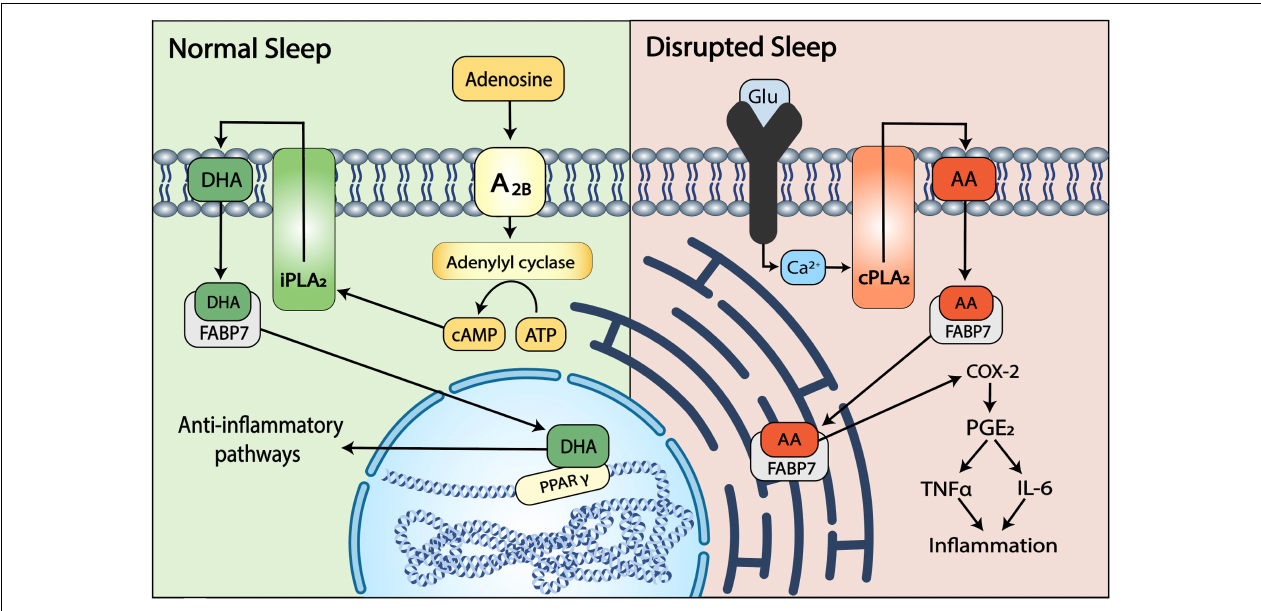
FIGURE 2 | A dichotomous role for FABP7 in AD. Depending on the relative activity of cPLA 2 and iPLA 2 , AA and DHA are released from the phospholipid membranes of astrocytes. Upon release, AA or DHA bind FABP7 to initiate distinct signaling cascades within the cell. Under conditions of normal sleep (left), the sleep promoting substance adenosine activates adenosine receptors (A2B) that signal adenylyl cyclase to increase cAMP levels, leading to the cAMP-dependent activation of iPLA 2 and subsequent release of DHA from the membrane. The released DHA binds to FABP7 and is translocated to the nucleus where it activates the anti-inflammatory transcription factor PPAR γ , leading to the induction of sleep-mediated neuroprotective pathways. With disrupted sleep (right), wakefulness-associated increases in glutamate result in increased levels of intracellular Ca 2 + that activate cPLA 2 to release AA from the membrane to bind FABP7. FABP7 then delivers AA to the endoplasmic reticulum, triggering a COX-2:PGE 2 -dependent pro-inflammatory cascade and cytokine (TNF α and IL-6) –mediated progression of